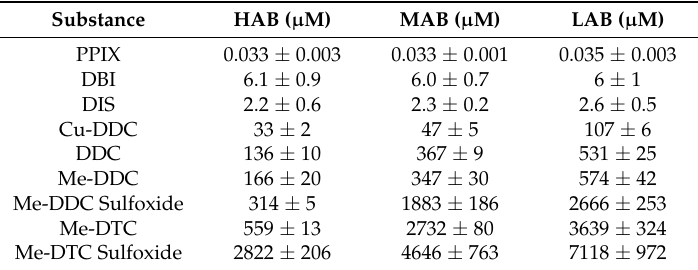
Table 1. Inhibition constants ( K i ) of the tested substances toward 18 kDa translocator protein